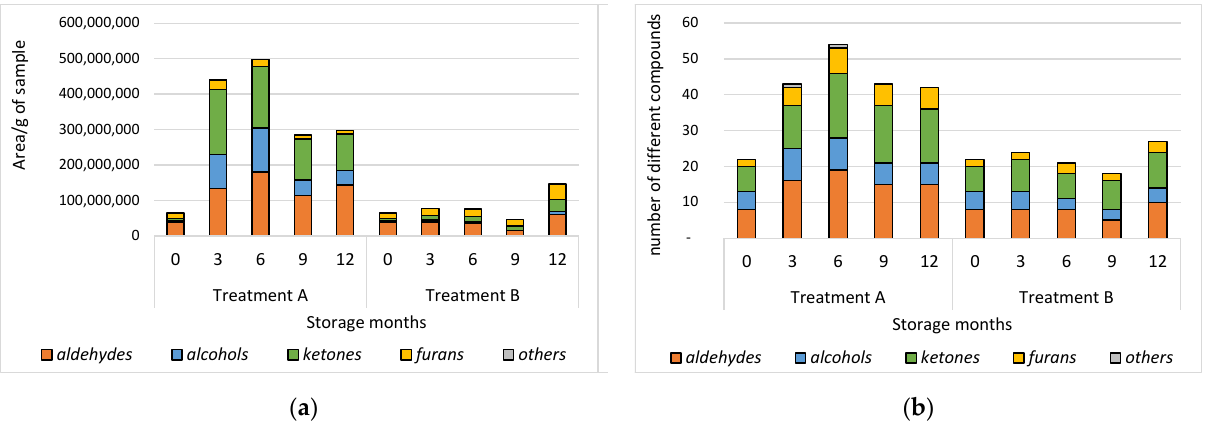
Figure 2. ( a ) Evolution of the total amount of volatile compounds during the ageing ( n = 3); ( b ) Evolution of the number of different volatile compounds during the ageing ( n = 3). Treatment A: 20 °C—Light, Treatment B: 30 °C—Dark.